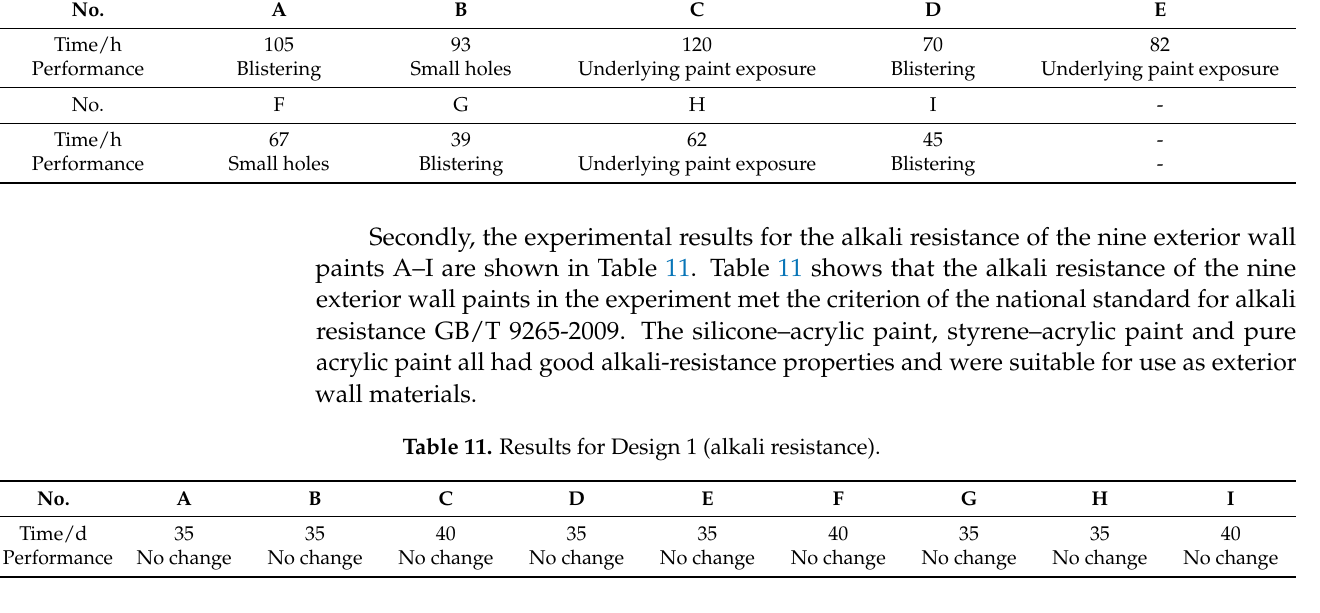
Table 10. Results for Design 1 (water resistance II).